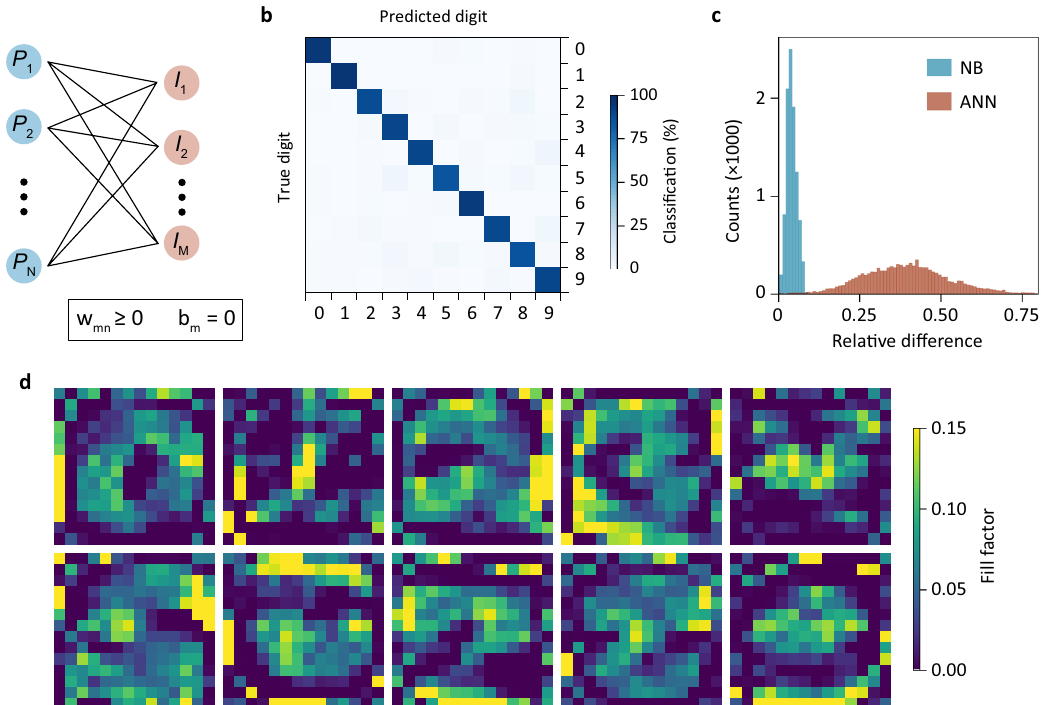
Figure 4. ANN photosensor. ( a ) Sketch of the ANN with weight and bias constraints. ( b ) Confusion matrix for the ANN sensor. ( c ) Relative difference between the highest and all other output currents. The ANN exhibits a larger spread in output currents than the NB classifier. ( d ) Superpixel shapes for the ANN.